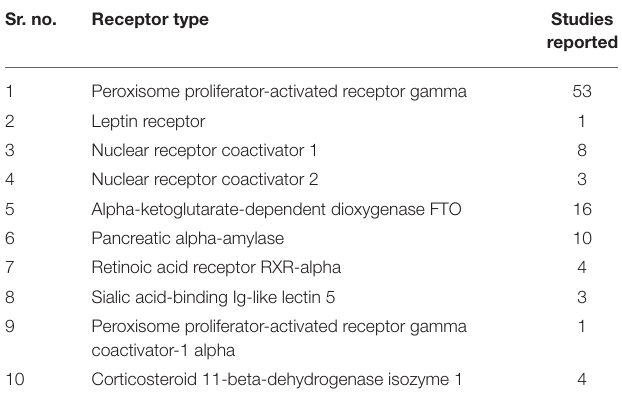
TABLE 1 | Major receptors studied for anti-obesity activity for various ligands. Sr. no.